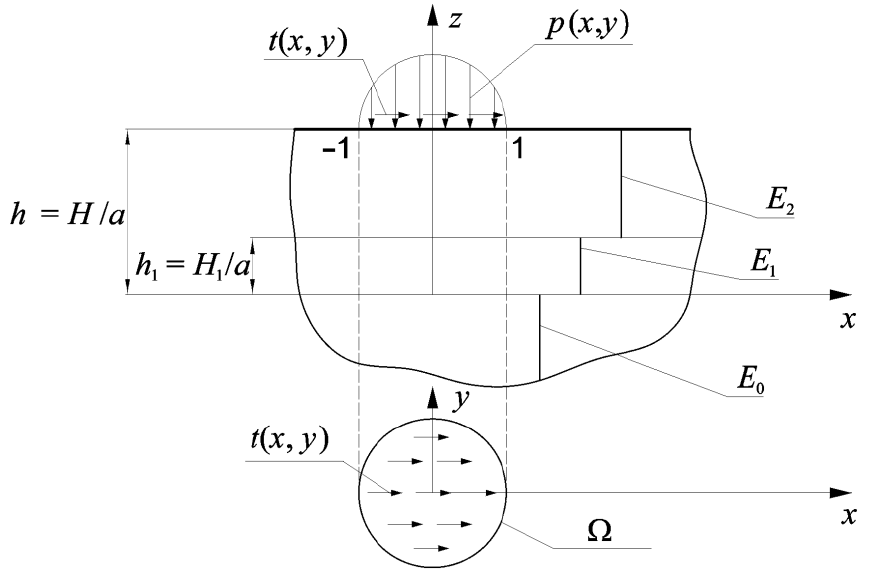
Figure 1. The scheme of the problem.